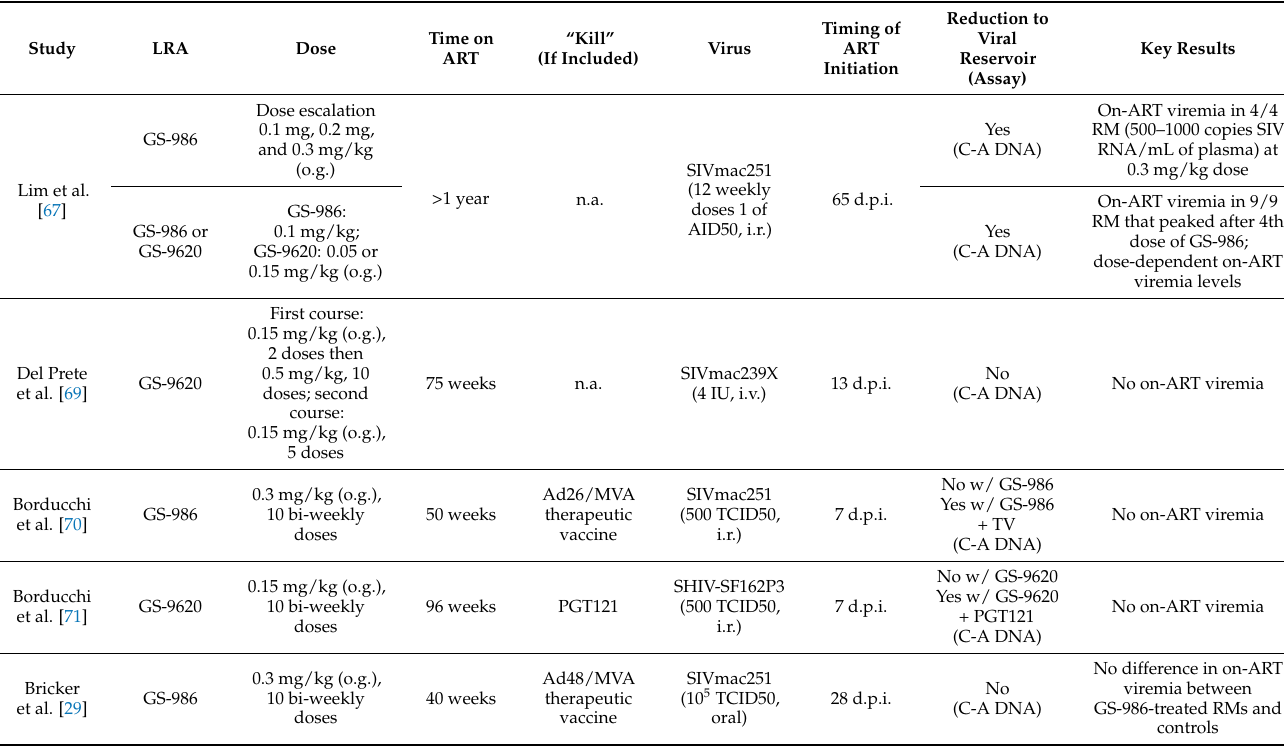
Table 4. Recent NHP studies testing TLR agonists as an LRA. TLR, Toll-like receptor, o.g., oral gastric; AID50, 50% animal infectious dose; i.r., intrarectal; IU, infectious units; i.v., intravenous; TCID50, 50% tissue culture infectious dose; d.p.i., days post-infection; RM, rhesus macaque; C-A, cell-associated. Study LRA Dose Time on ART “Kill” (If Included) Virus